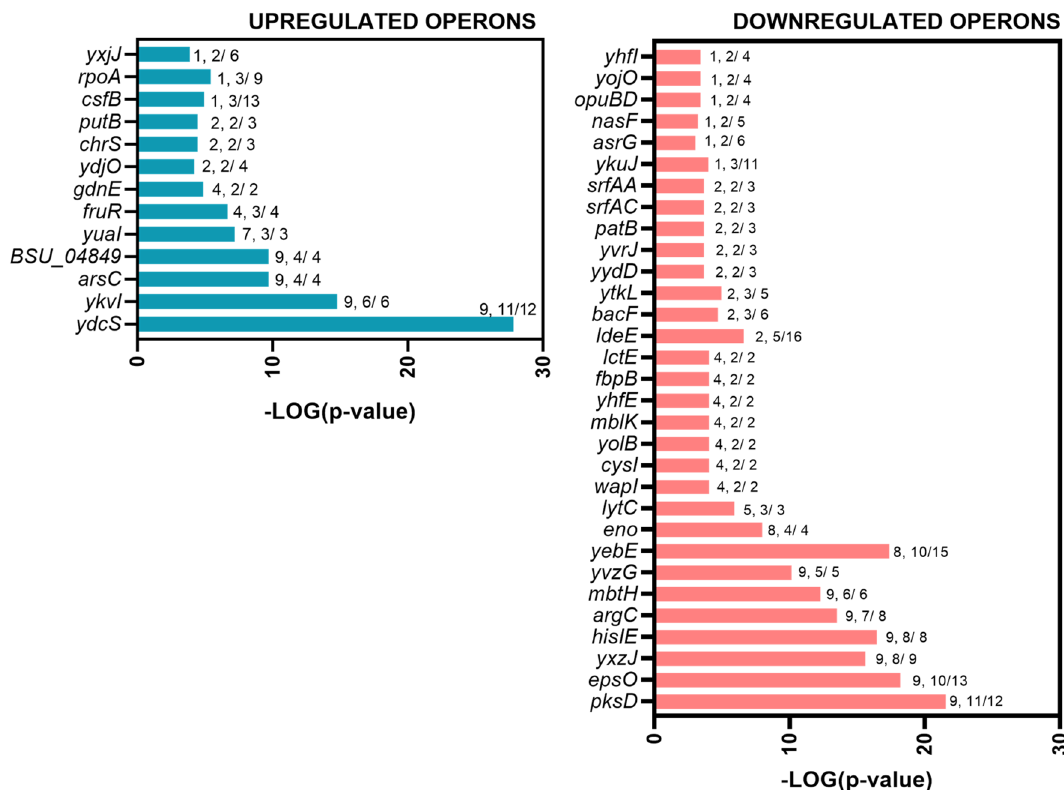
Figure 3. Significantly affected gene expression organized in operons for B. subtilis VBNC cells. A graphical representation of DEGs ( p value ≤ 0.05 and a log 2 FC ≥ 3) clustered in operons. The values given to each bar correspond to Score (0–9, 0 being not significant, ranked based on Benjamini–Hochberg Algorithm) and the hits/class size.